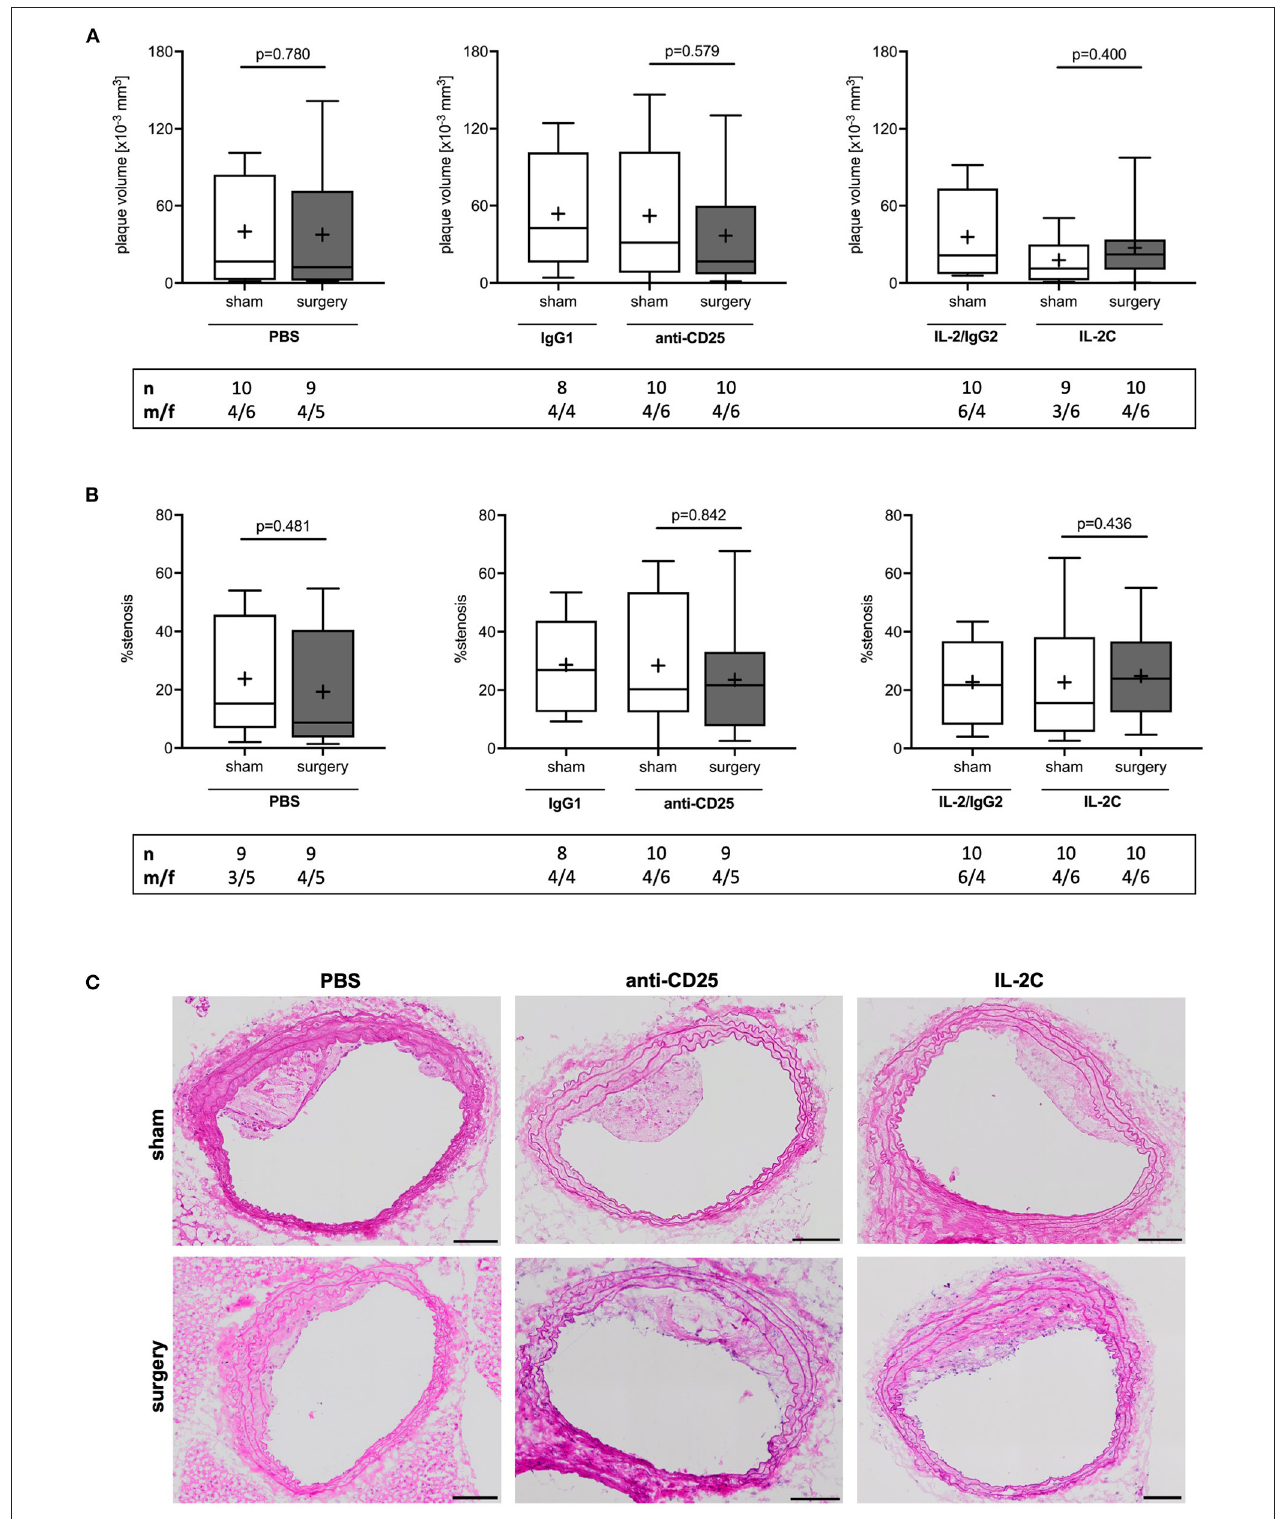
FIGURE 3 | Postoperative plaque volume and stenosis in mice with preoperatively modulated Treg levels. Atherosclerotic ApoE − / − mice with modulated Treg levels were subjected to perioperative stress consisting of 30min laparotomy combined with moderate blood loss. (A) Atherosclerotic plaque volume of the